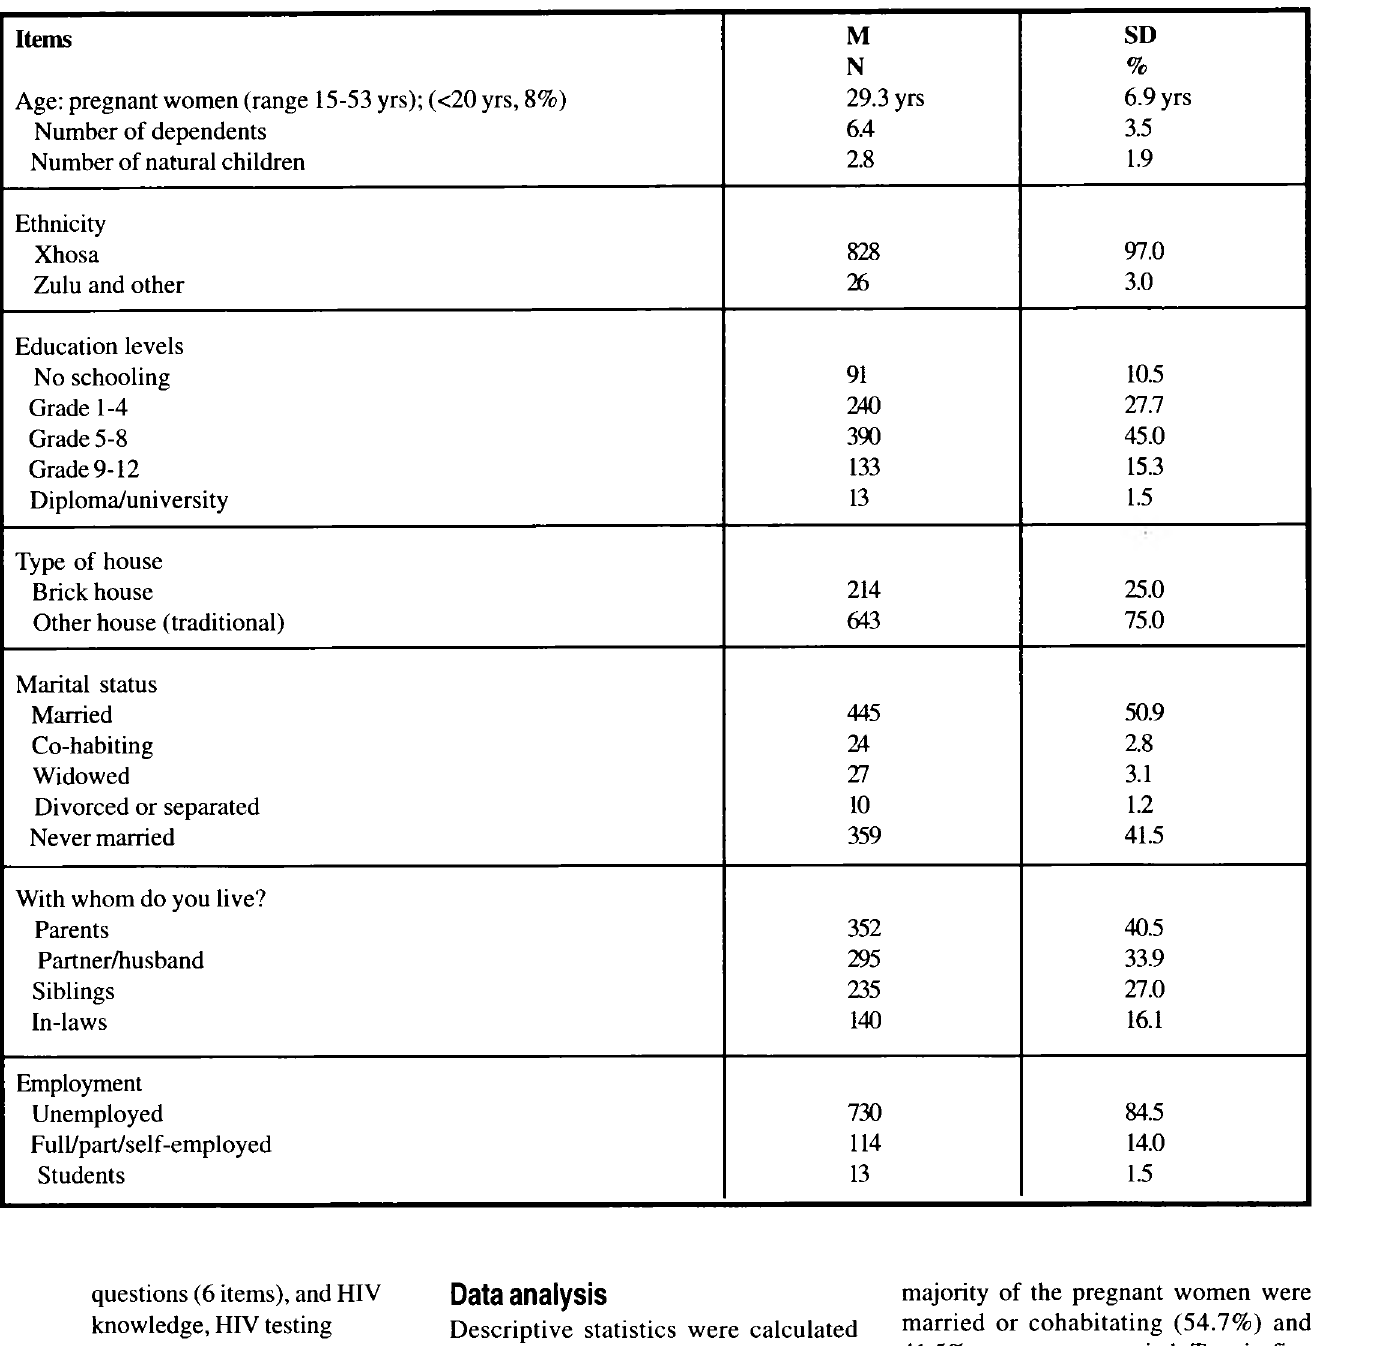
Table 1: Sample characteristics